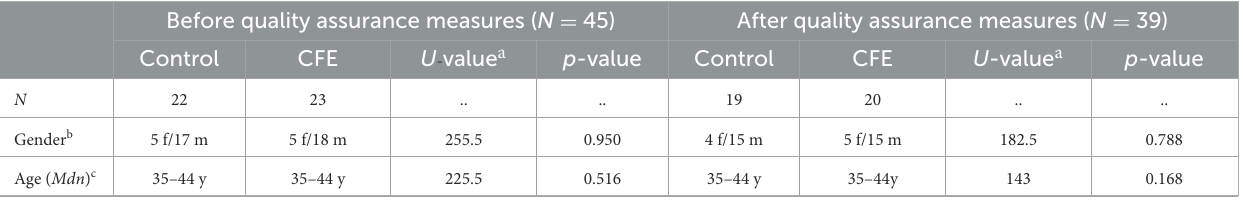
TABLE 1 Demographic information of participants in Experiment 1.